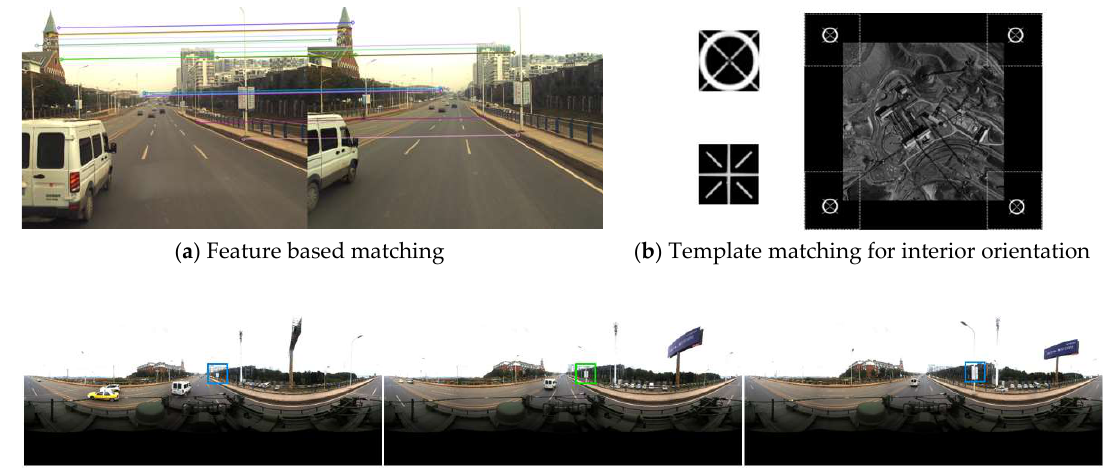
Figure 1. Some examples of image matching. ( a ) shows the feature-based matching method that firstly extracts arbitrary features (denoted by small circles) from images and then matches them (denoted by lines); ( b ) shows a traditional temple matching case that uses the corresponding template patch to locate four fiducial marks in an aerial image; ( c ) shows the template matching case in our study. Given an object or patch (denoted by green box) in one image, the corresponding objects (denoted by blue box) with significant distortion should be retrieved from multi-view panoramic images.